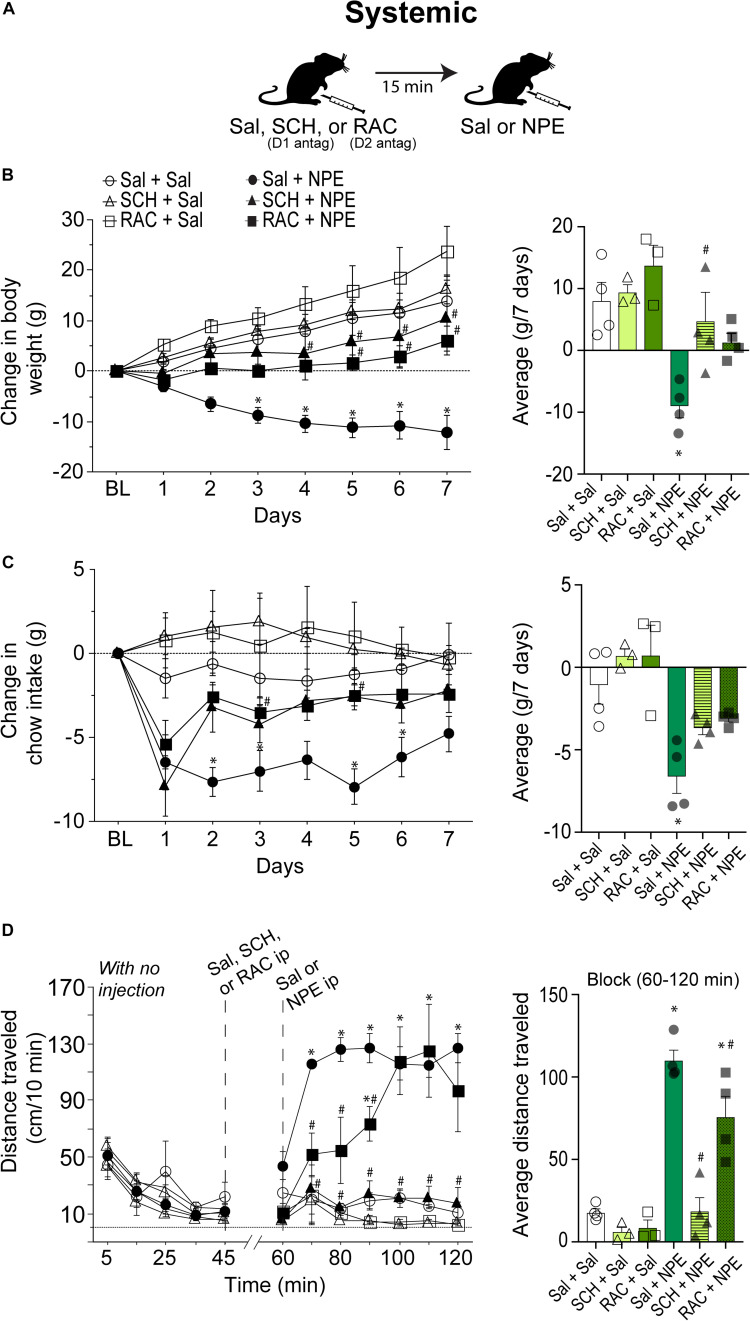
Intraperitoneal injection of either D1 (SCH23390- SCH) or D2-like receptor [raclopride (RAC)] antagonists partially reversed NPE -induced behavioral effects. (A) Scheme of i.p. injections. (B)
Left panel: Change in body weight over 7 days relative to BL (first day of injection). NPE was given in a fixed dose of 20 mg/kg. Right panel: The average change in body weight. (C)
Left panel shows the change in chow intake (g). Right panel: The average change in food intake. (D)
Left panel: Distance traveled (cm/10 min) for a period with no injection (interval 0–45 min), and the evoked distance after NPE or Sal (>60 min). The first i.p. injection (Sal, SCH, or RAC) was given at 45 min, which is 15 min before the second injection at 60 min (Sal or NPE, note: the break-in x-axis at 45–60). Right panel: Average distance traveled. ∗p < 0.05 significantly different than in Sal + Sal. #p < 0.05 compared to Sal + NPE group.